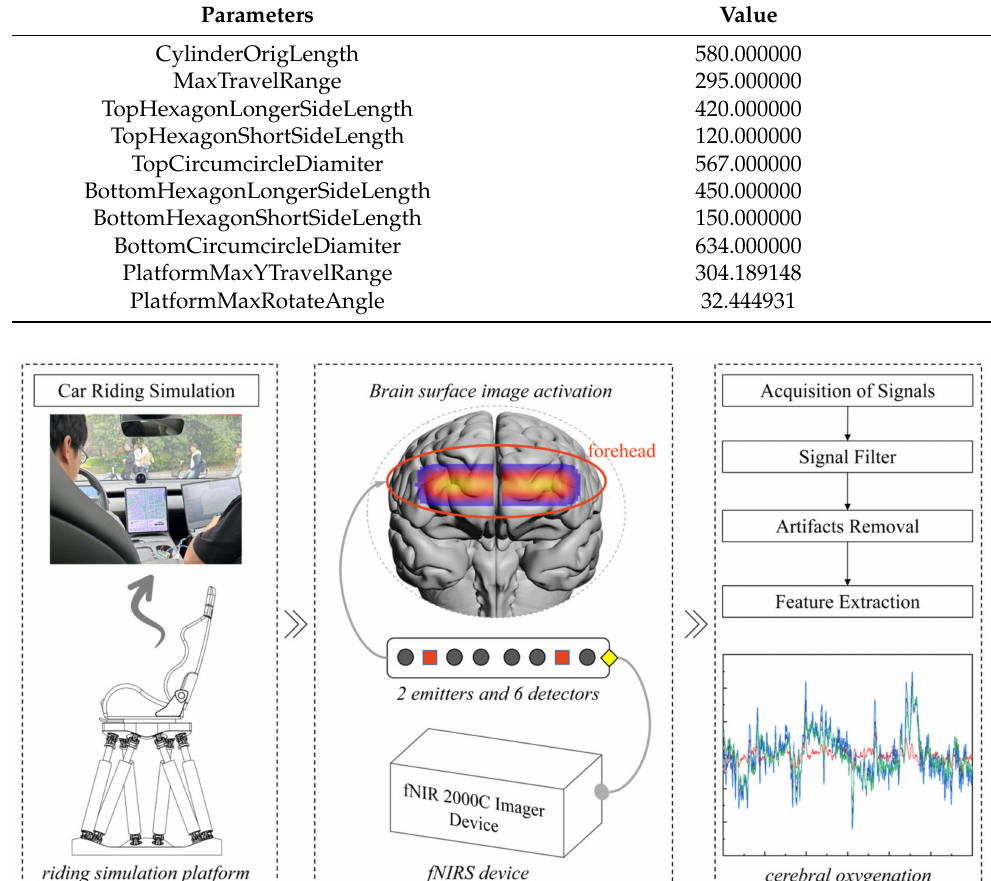
Table 1. Parameters of the 6-degree-of-freedom platform.